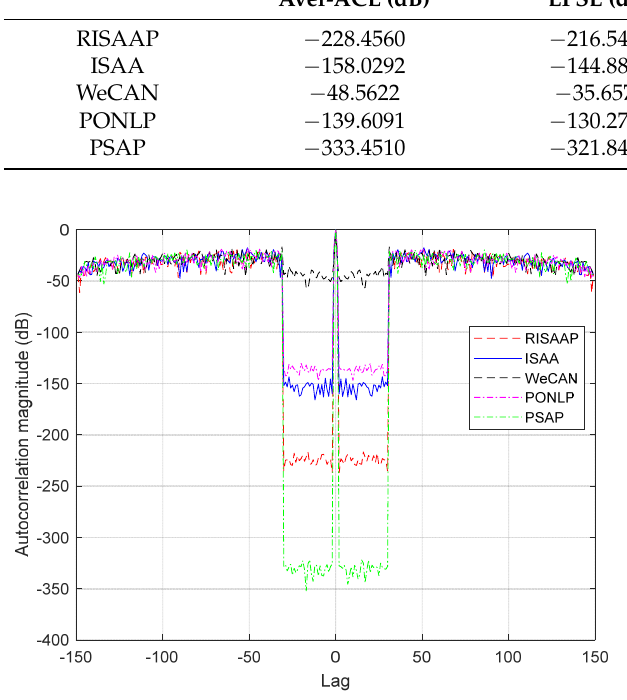
Figure 1. ACL comparison for suppressing sidelobes in a single area.